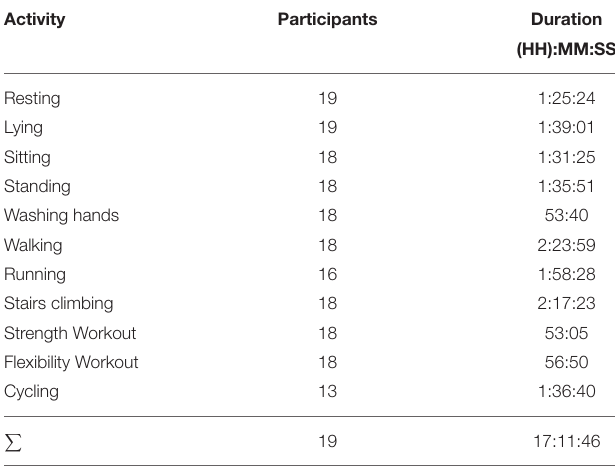
TABLE 1 | Summary of the activities included in the harAGEdataset, the number of participants collected for each activity, and the amount of data available